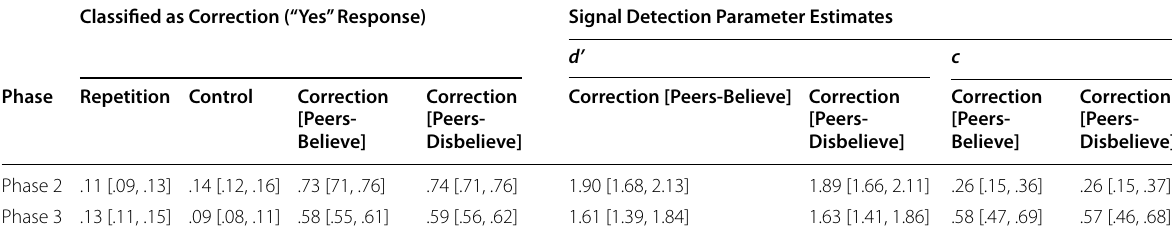
95% confidence intervals are displayed in brackets